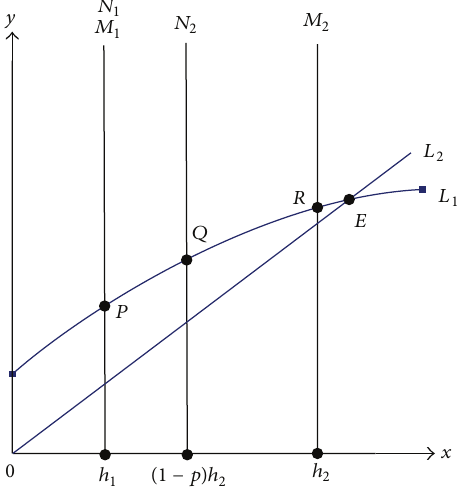
Figure 2: The structure graph of system